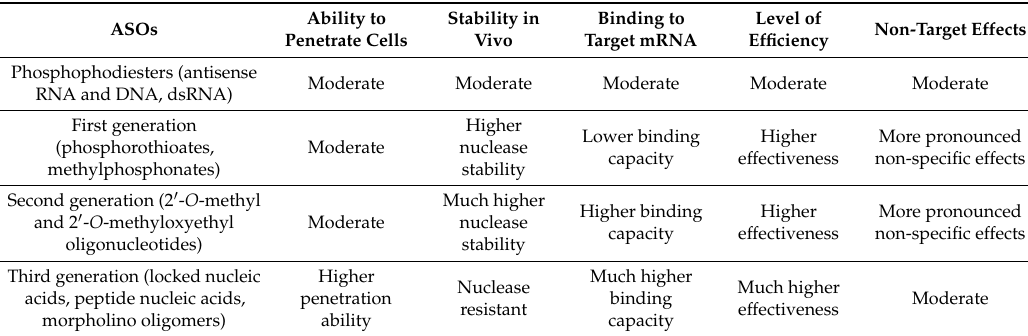
Table 1. Summary of properties of three generations of antisense oligonucleotides in comparison with phosphodiesters. Ability to Stability in Binding to Level of ASOs Penetrate Cells Vivo Target mRNA